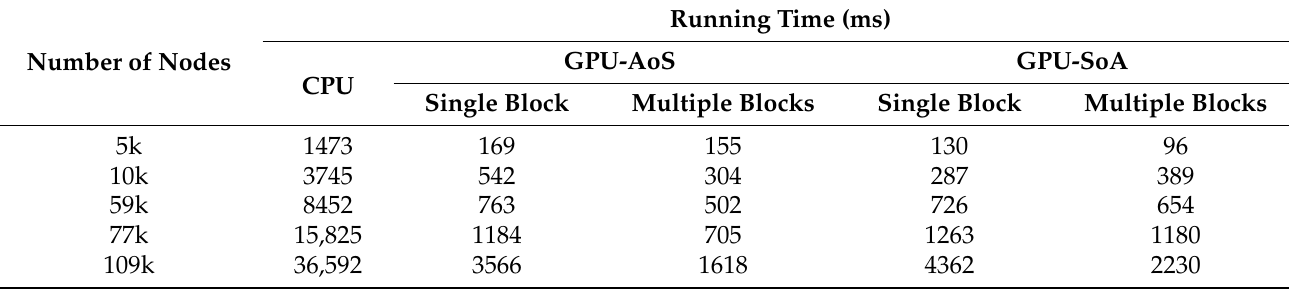
Table 4. Running time of the proposed algorithm when using Form